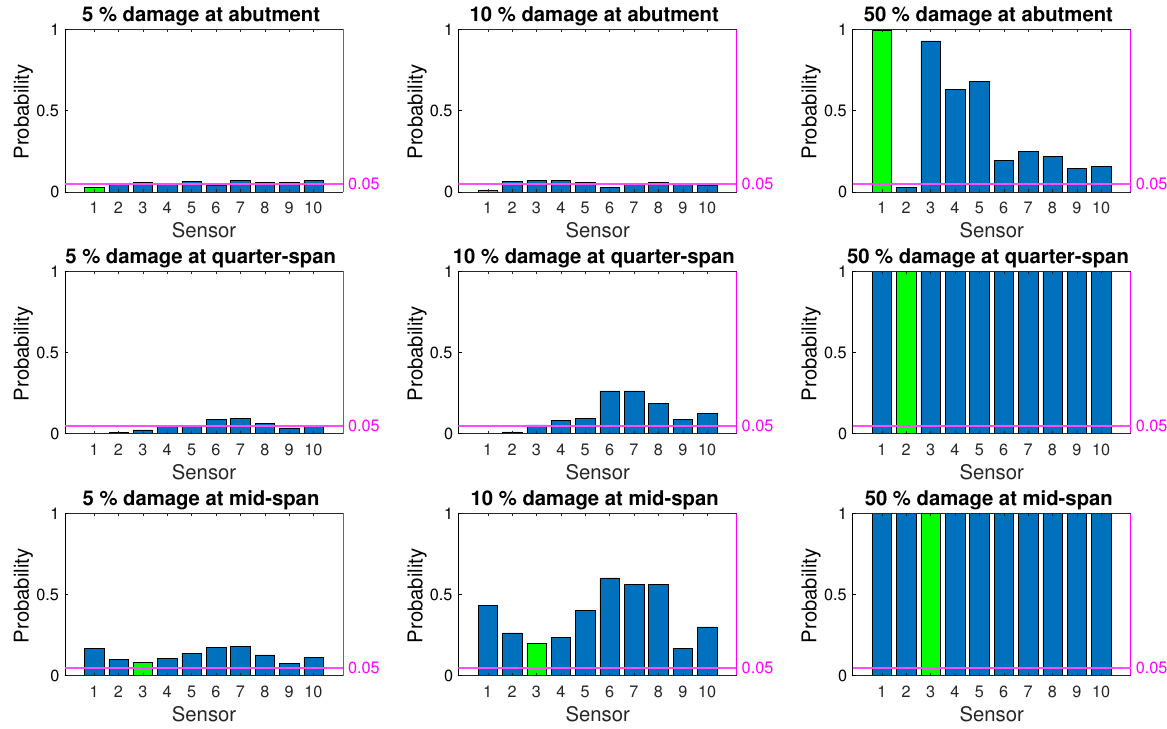
Figure 10. Probability of damage detection using modal flexibility damage indicator for 5% noise. A parameter that has the potential to impact the probability of successful damage detection and localization is noise. In order to evaluate the impact of noise, the